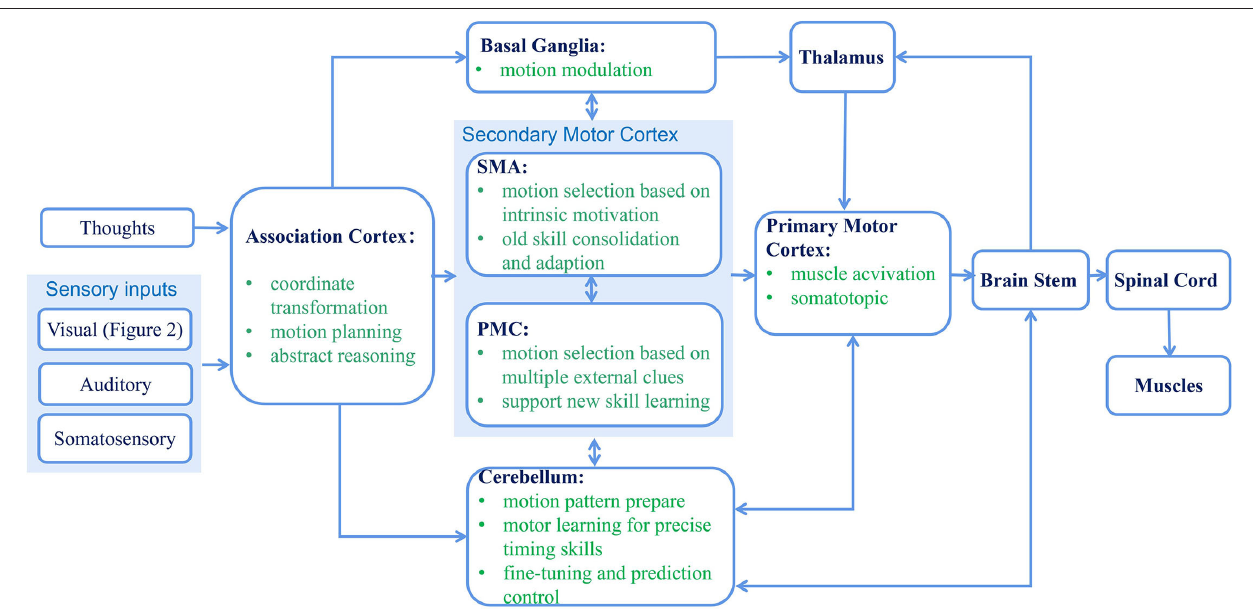
FIGURE 3 | Simplified diagram of the sensorimotor system. The green texts in each block explain the functions of the corresponding area. Note that various cross-layer and inter-layer feedforward and feedback connections existed for sensorimotor modulation and adaptation, which are not shown in this figure for brevity ( Middleton, 2000; Shmuelof and Krakauer, 2011; Gazzaniga, 2014).